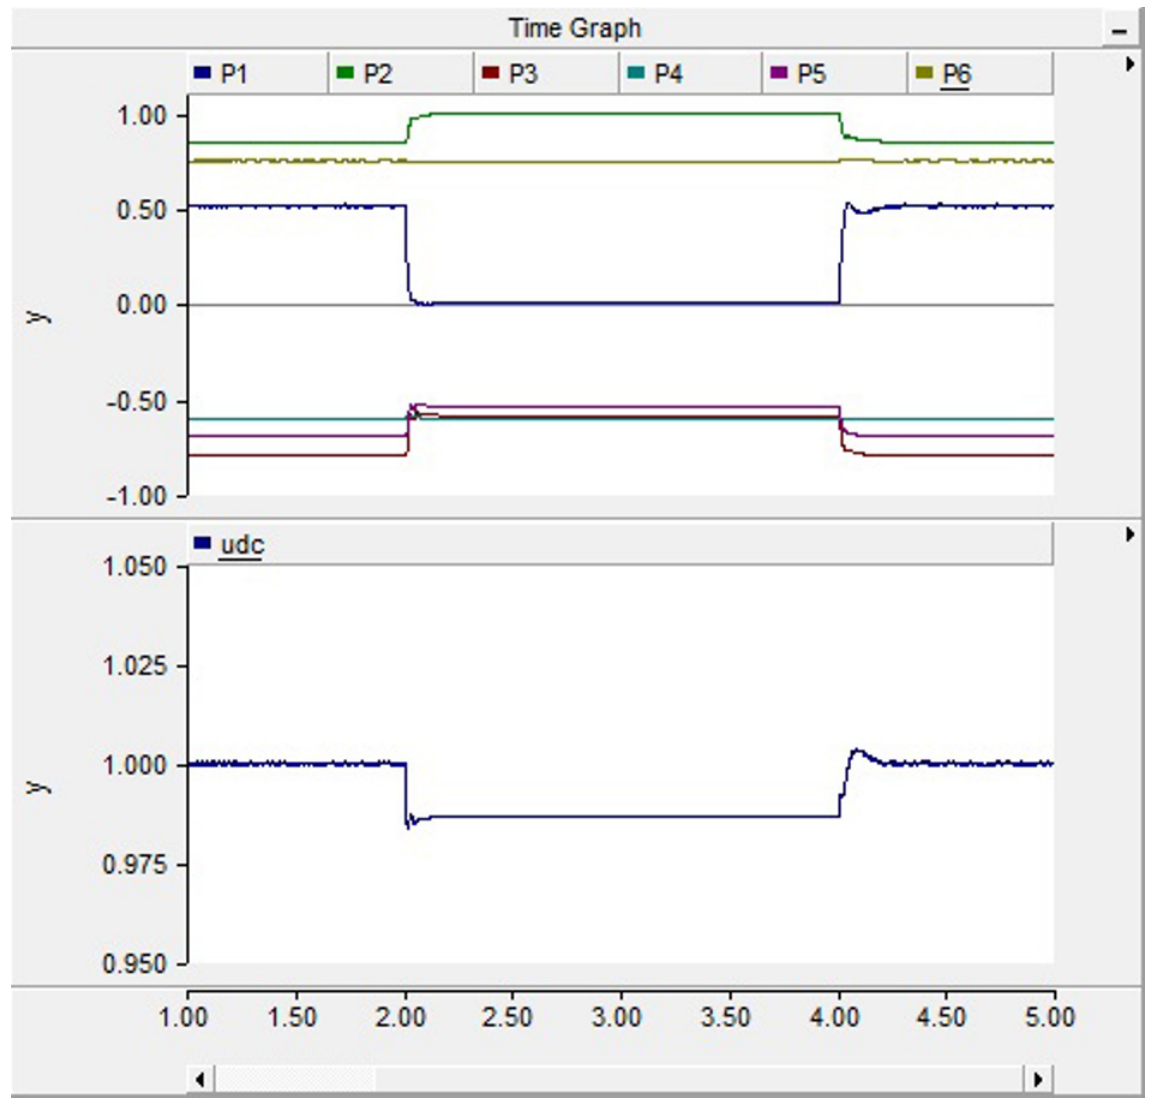
Figure 12. Responses at loss of VSC